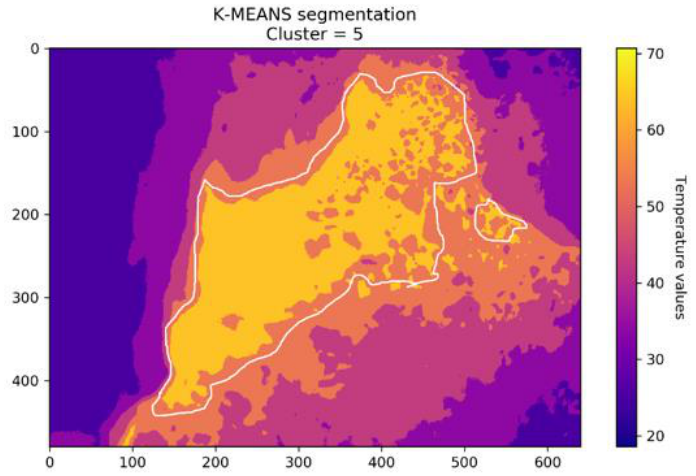
Figure 6. Example of the previous segmented image where the hot segment is highlighted: it will then further break up using the DBSCAN algorithm. As for Figure 5, not all the intervals of temperature are shown on the image as each segment is represented with its average temperature. Temperatures are in °C.